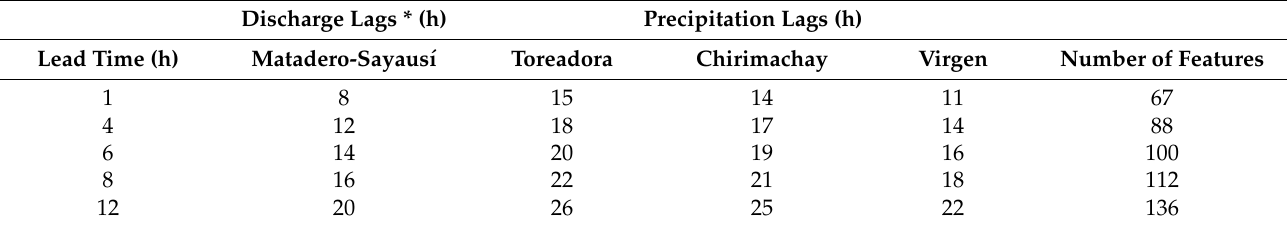
Table 2. Input data composition (number of features) for all ML models of the Tomebamba catchment.